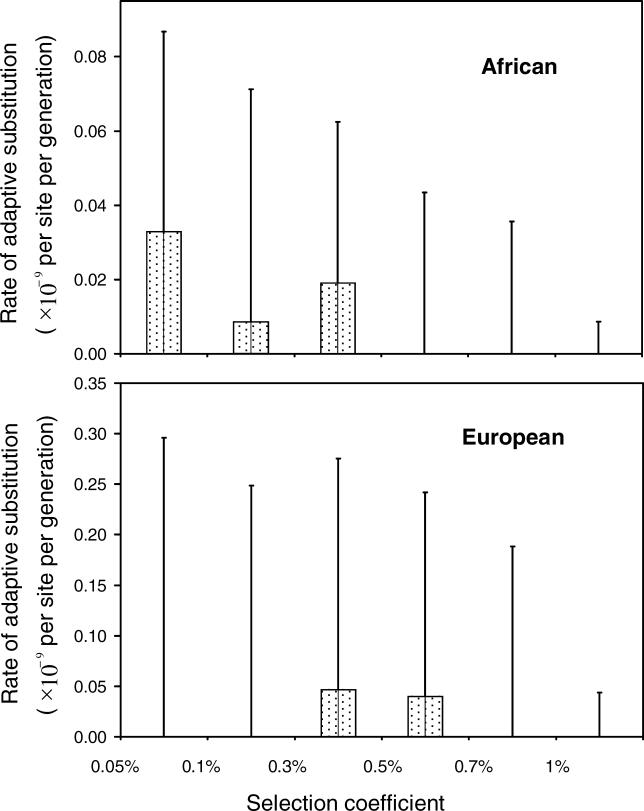
The Frequency Spectrum of Selection Coefficients (s) for Recent Positive Selection in the African and European PopulationsThe y-axis shows the rate of adaptive substitution with an s value in (s1, s2) if all selectively driven substitutions occur in coding regions. The 95% likelihood-based CIs are given as error bars.